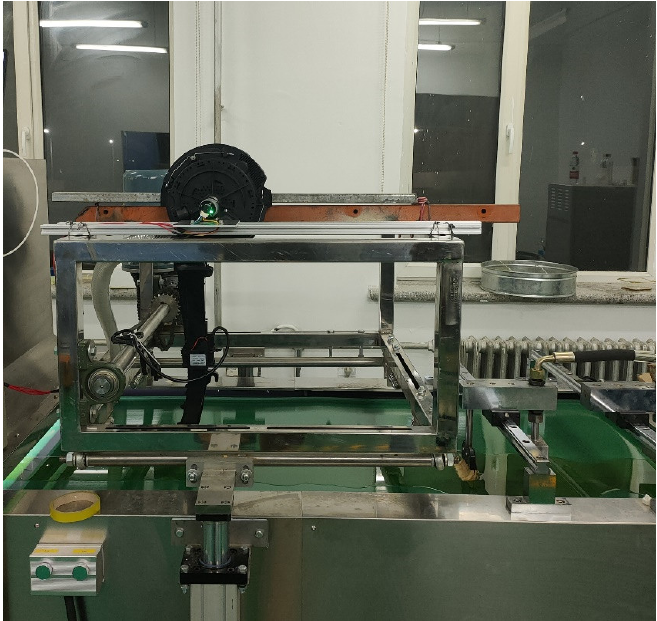
Figure 8. Seed metering device speed accuracy experiment. Table 4. Verification experiment table of seed metering device speed accuracy.